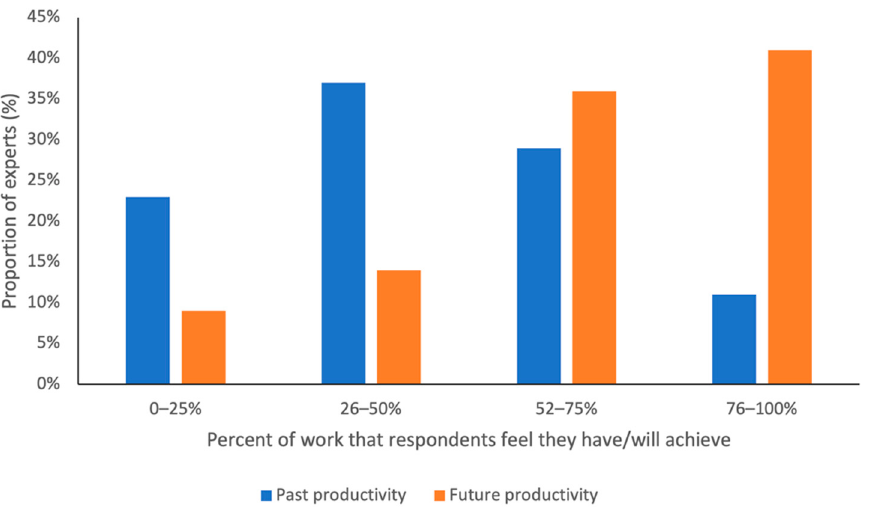
Figure 1. Self-reported work productivity by respondents in the past (from March 2020 to March 2022) and into the future (into the next two years). Respondents were asked to estimate how much they had managed to achieve (from four categories) relative to what they would have achieved had the COVID-19 pandemic not